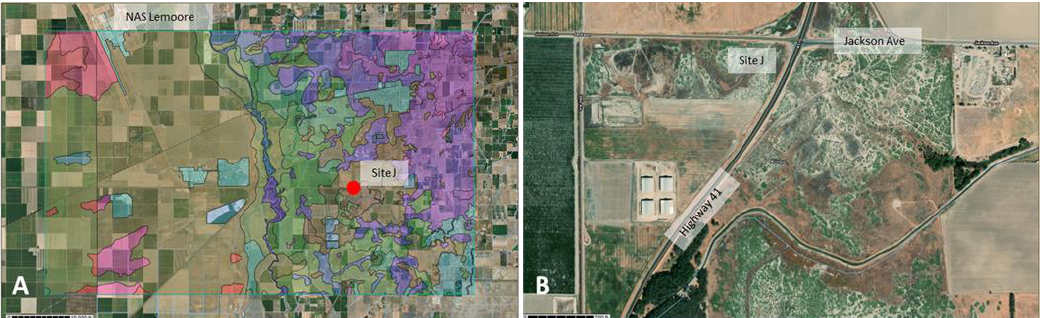
Figure 12. Location of C. immitis DNA-positive site J southeast of NAS Lemoore (red dot). Different soil types are indicated in colors with Boggs and Lemoore sandy loam in brown. These types of soils comprise ~6.5% of the area of interest (AOI) in this picture ( A ). Magnified satellite view of site J showing the extent of soil disturbance and its proximity to Highway 41 and Jackson Avenue, two highly frequented roads south of Lemoore ( B ).